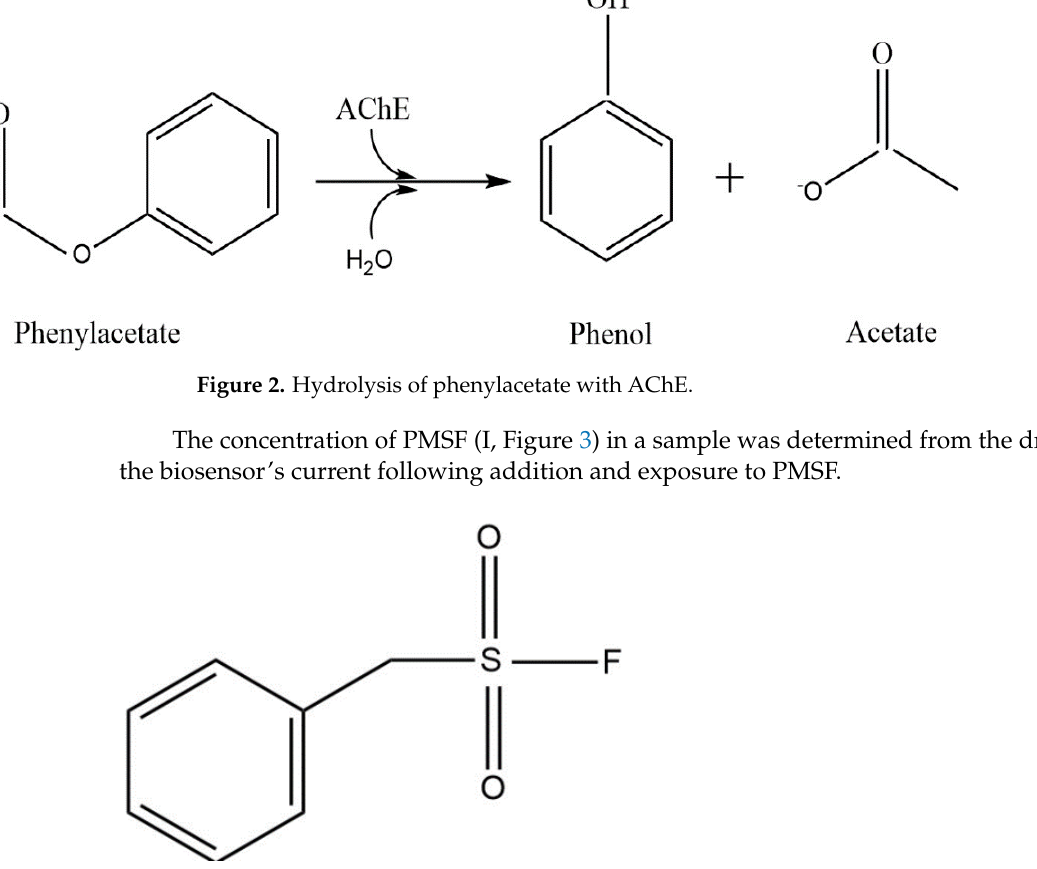
Figure 1. Schematic representation of reactions in the IBE biosensor interface. S 1 , S 2 , S 3 , and S 4 denote phenylacetate, phenol, catechol, and o-quinone, respectively. E 1 , E 2 , and E 3 denote acetylcholinester- ase, tyrosinase’s phenolase activity, and tyrosinase’s catecholase activity, respectively.